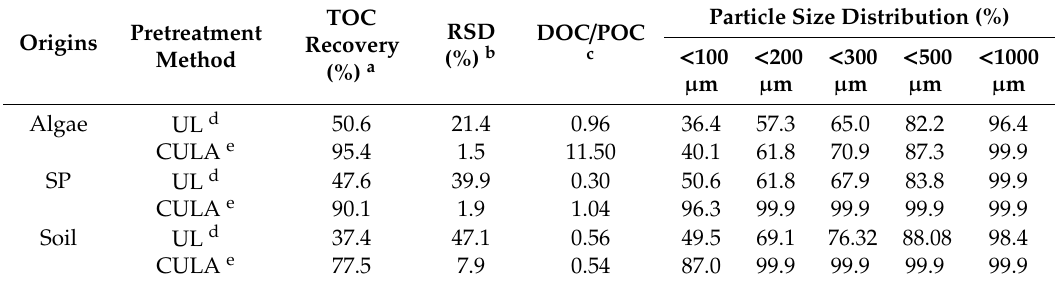
Table 1. Results of the total organic carbon (TOC) and particle size distribution analysis of water samples containing suspended solids (SS) with di ff erent origins depending on the